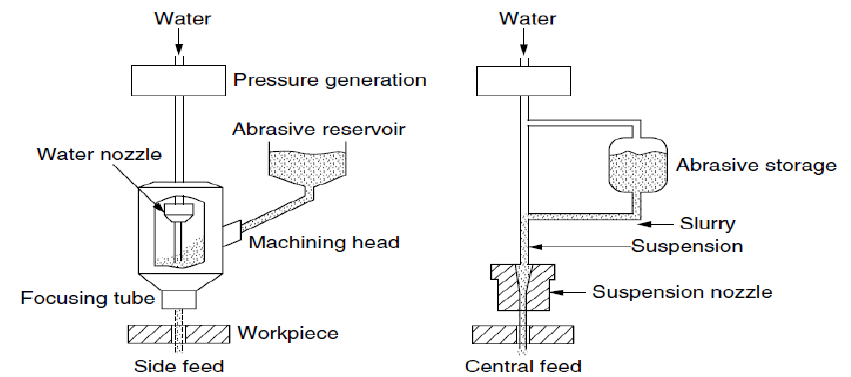
Figure 4: injection and suspension system [17].